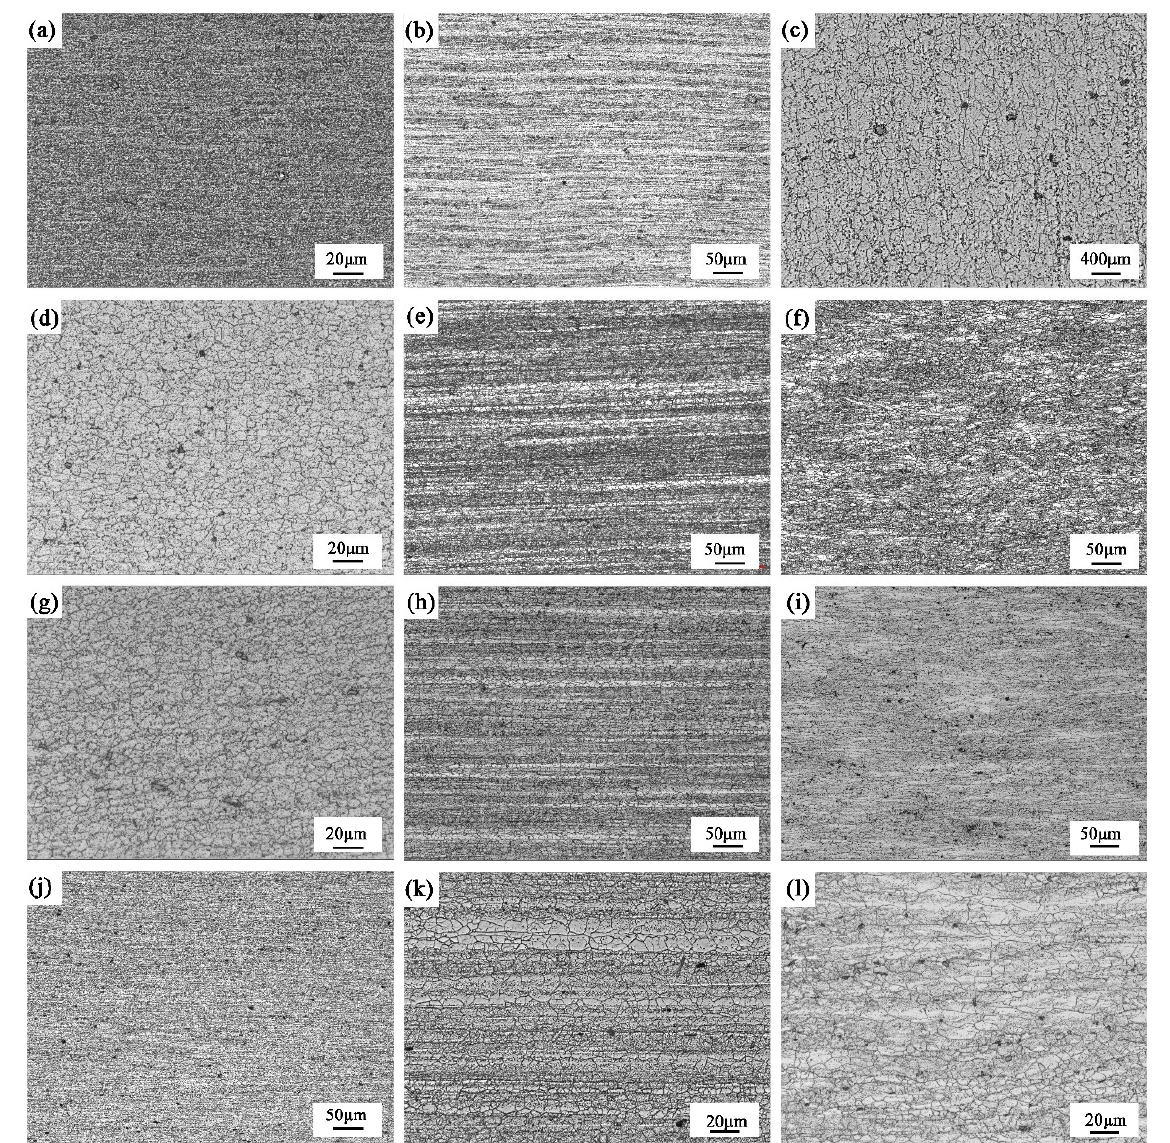
Figure 3. Micrographs of different sections in 7B05 aluminum alloy: ( a ) parallel rolling direction of T4-6, surface, ( b ) parallel rolling direction of T4-6, center, ( c ) vertical rolling direction of T4-6, center; ( d – f ) the corresponding T4-15 microstructures; ( g – i ) the corresponding T5-10 microstructures; ( j – l ) the corresponding T5-15 microstructures.